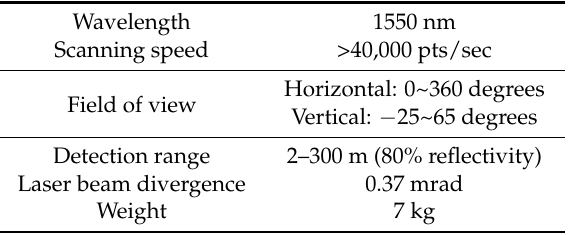
Table 1. Parameter of STONEX